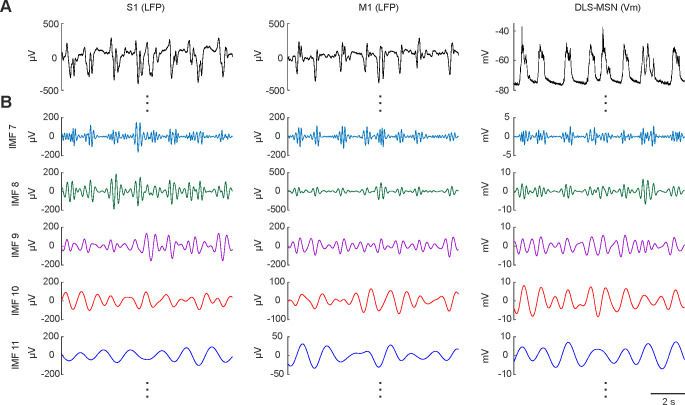
Example of decomposition of different traces by the NA-MEMD.(A) Example traces of a S1 LFP (left), M1 LFP (center), and a whole-cell recording in DLS (right). (B) Consecutive IMFs obtained by applying NA-MEMD to the signals in a, starting from the seventh IMF. The IMF classifies the oscillatory activity from the fastest to the slowest.